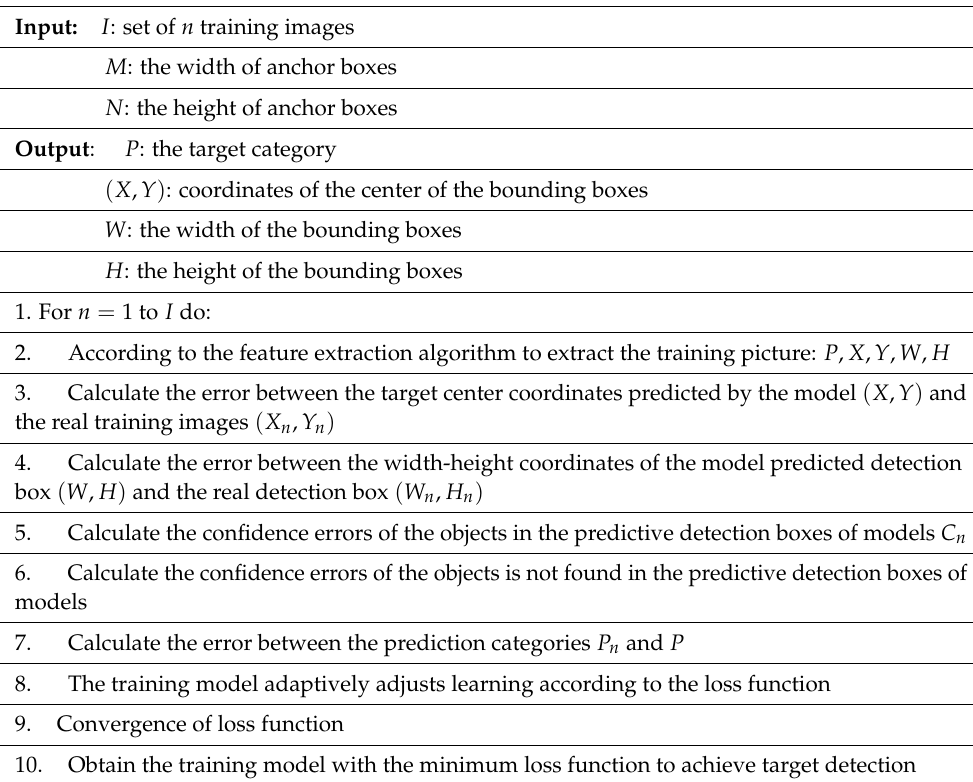
Algorithm 2 The pseudocode of training model.